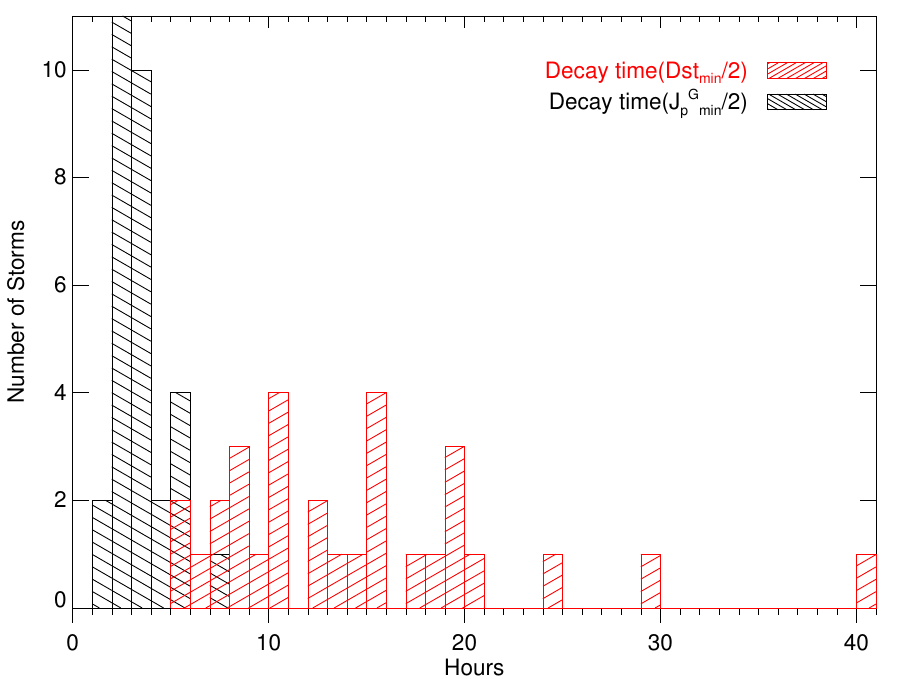
Figure 9. Distributions of magnetic storm recovery durations, the start and end time of the recovery phase are the time when the geomagnetic index is at the minimum value and the time when the geomagnetic index is restored to 1/2 of the minimum value, the red is the Dst index, and the green is the J G p